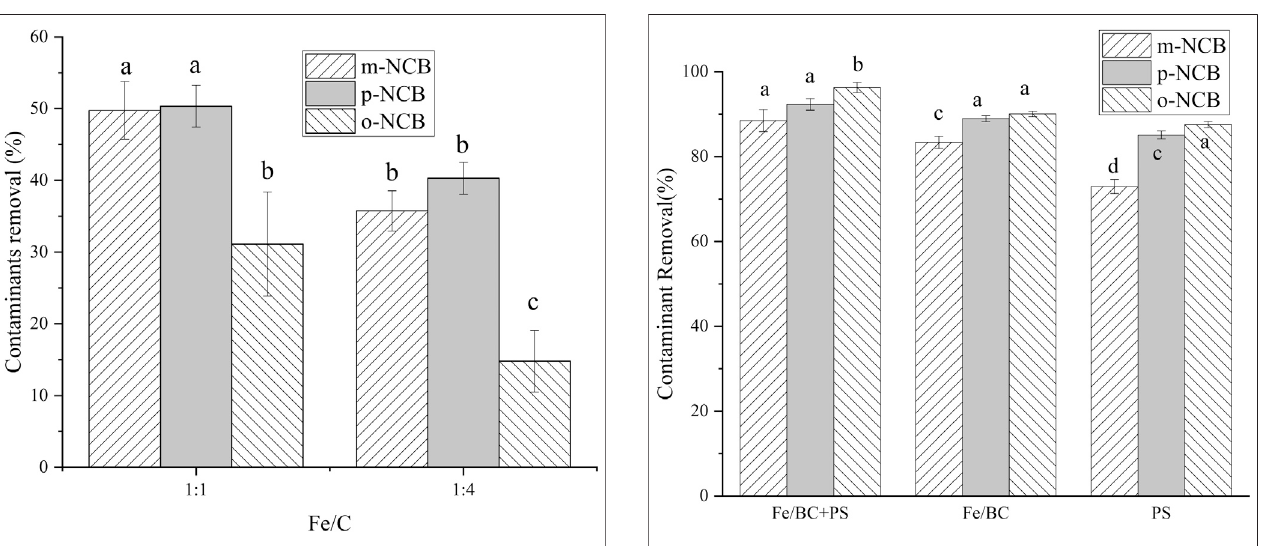
FIGURE4| NCB degradation indifferentsystems.ThenZVI/BC amount 0.02 g,Fe/PS molarratio1:1,the initialNCB isomerconcentration10 mg L − 1 , and the reaction time 2 h.